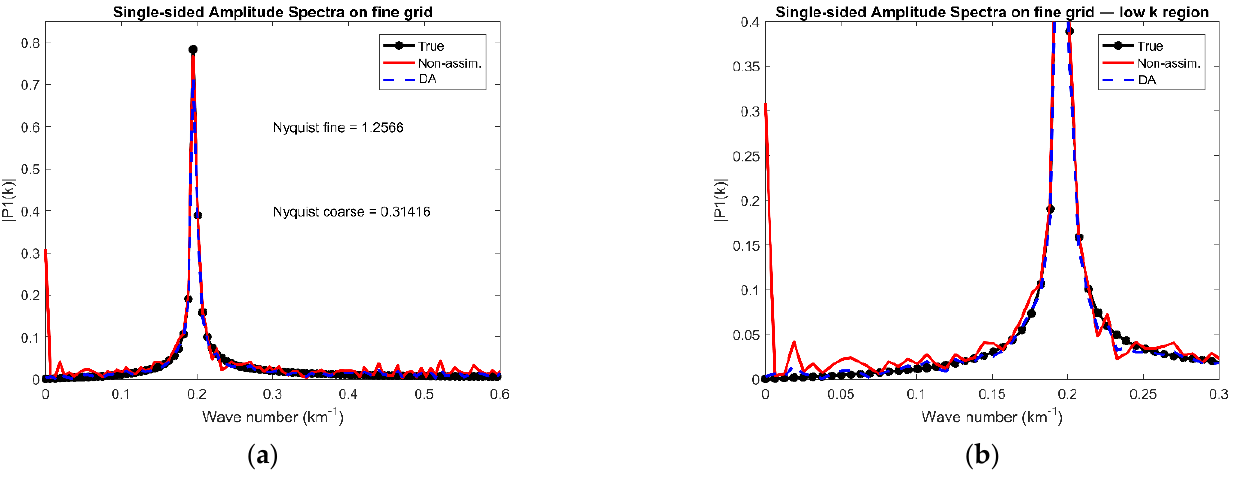
Figure 16. Amplitude spectra on a zonal transect at 𝑦 = 40 km for the example of multiple eddies of 𝐿 𝑥 = 16 km. The STD of noise in the non-assimilated child model is 0.15, bias is 0.3, and the spatial shift is 4 km to the west. The spectra are calculated for the true field, the child model forecast (before assimilation), and analysis (after assimilation). ( a ) Spectra in the full range of wave numbers and ( b ) zoomed in area for low wave numbers.